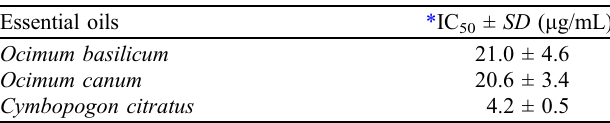
Table 5. Anti-plasmodial activity of essential oils on Plasmodium falciparum .